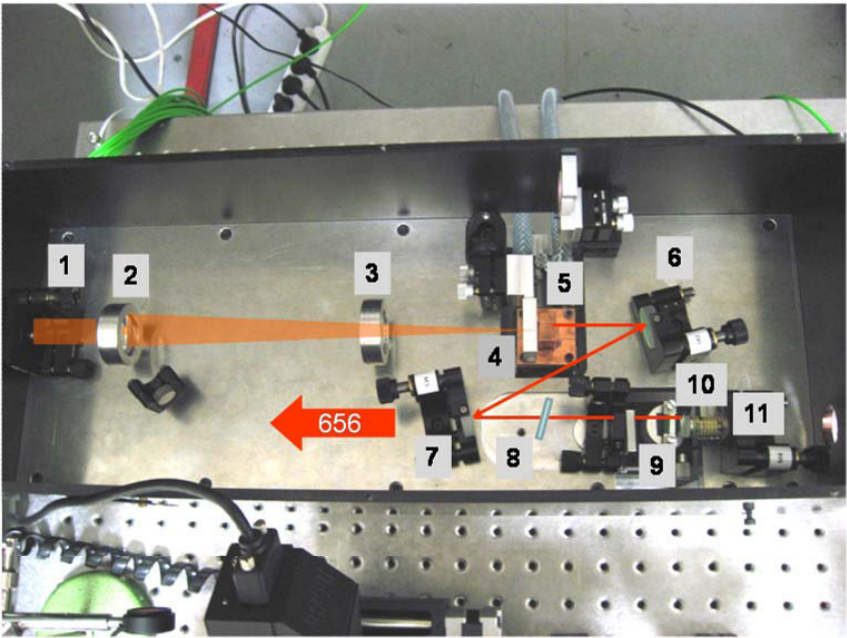
Fig. 5. (Color online) Photography of the Nd:YLiF 4 / β -BaB 2 O 4 linear cavity laser. 1: Diode pump, 2: Lens, 3: Lens, 4: Mirror M 1 , 5: Nd:YLiF 4 crystal, 6: Mirror M 2 , 7: Mirror M 3 , 8: Fused silica etalon, 9: β -BaB 2 O 4 crystal, 10: Mirror M 4 , 11: Piezoelectric actuator.